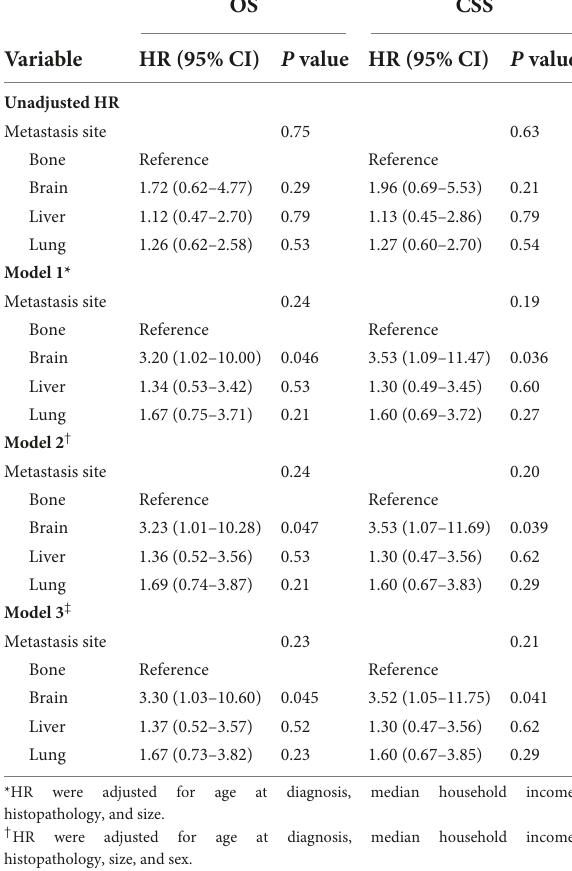
TABLE 3 The prognostic impacts of metastatic sites on patients with primary malignant cardiac tumors. OS